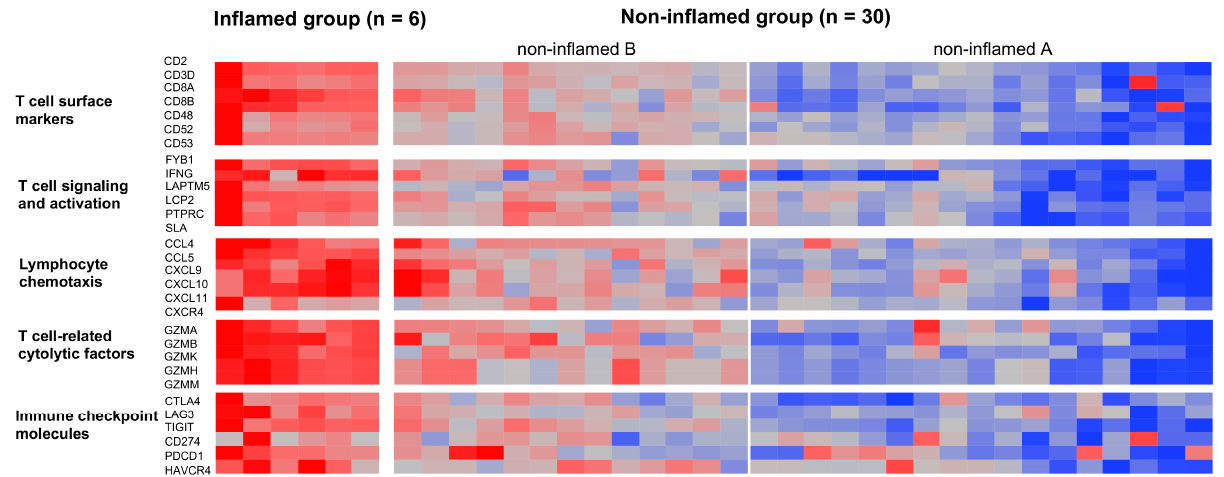
Figure 1. Hierarchical clustering analysis using z-scores of mRNA levels related to tumor-infiltrated lymphocytes. The color map ( red-gray-blue ): red , degree of increased mRNA expression; blue , degree of decreased mRNA expression. For clustering analysis, z-scores of mRNA levels of the following genes were used: CD2, CD3D, CD8A, CD8B, CD48, CD52, and CD53 as T-cell surface markers; FYB1, IFNG, LAPTM5, LCP2, PTPRC, and SLA as T-cell signaling and activation-related markers; CCL5, CXCL9, CXCL10, CXCL11, and CXCR4 as lymphocyte chemotactic markers; GZMA, GZMB, GZMK,